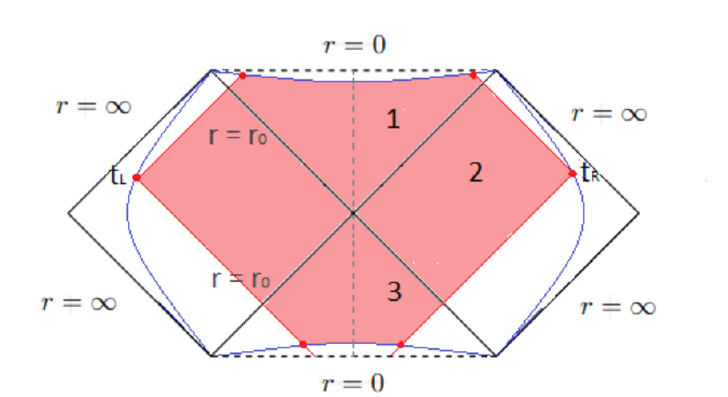
Figure 2 . Penrose diagram for the non-rotating BH, with the WDW patch for t b < t C